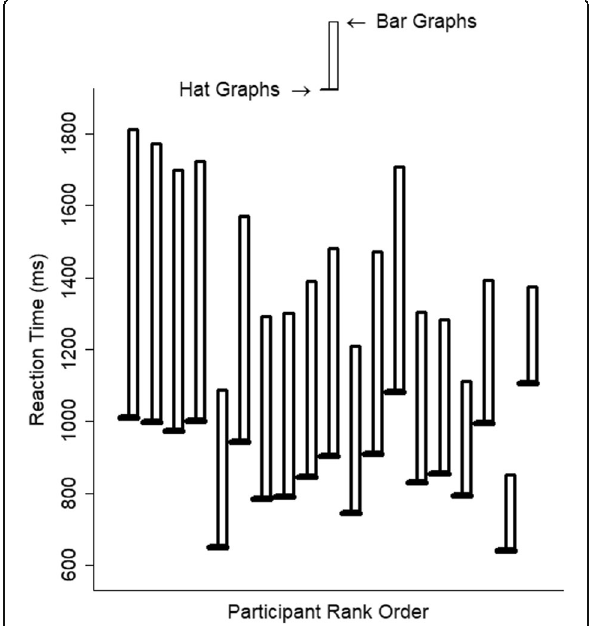
Fig. 4 Estimated reaction time (RT) is plotted as a function of graph type and participant for experiment 1. Estimates are based on the random intercepts and slopes. The brim of the hat corresponds to the RTs for the hat graph condition, and the top of the crown of the hat corresponds to RTs for the bar graph condition. The size of the crown indicates the difference in RTs between the two